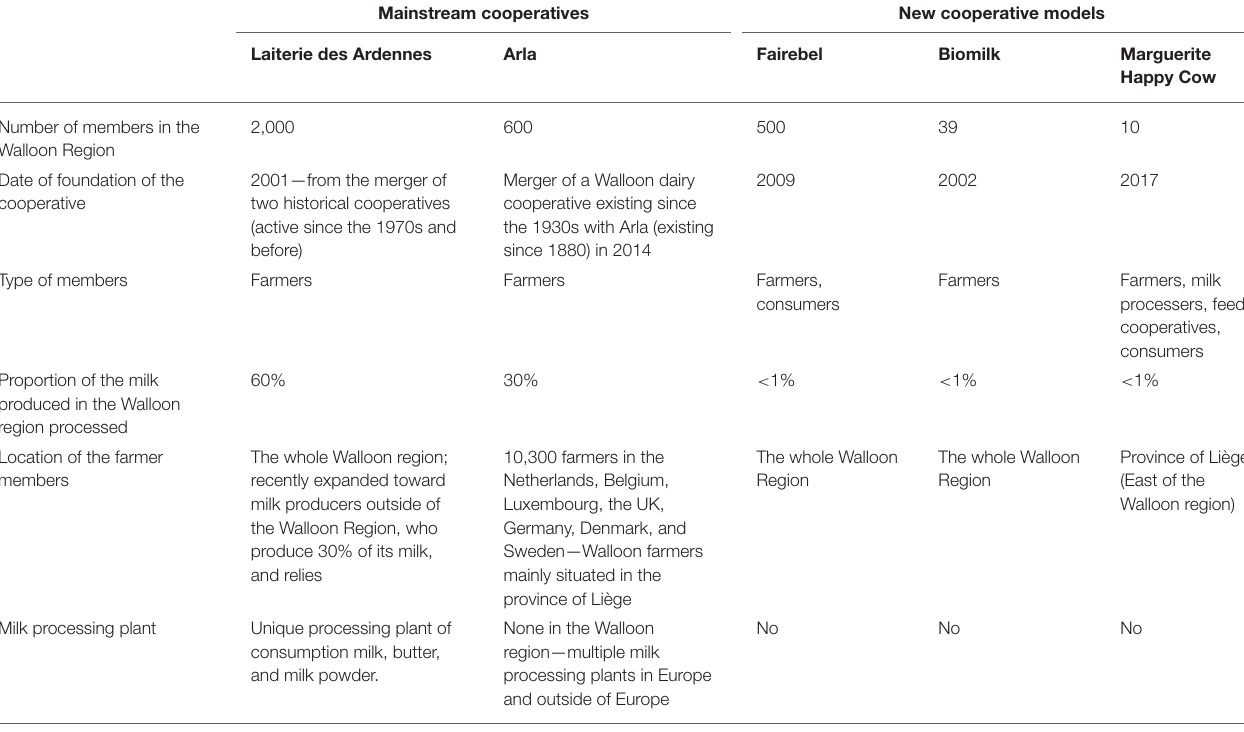
TABLE 1 | Characterization of the studied cooperative models, in terms of membership and activities.